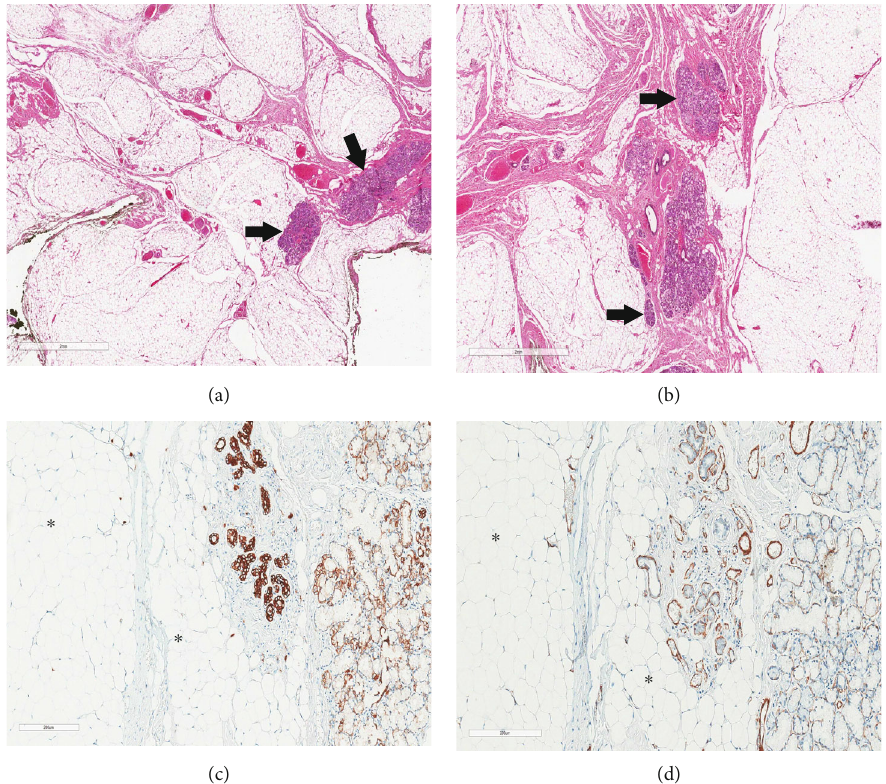
Figure 3: (a, b) Peripheral and inner areas of the tumor showing thin fi brous tissue capsule with numerous fat lobules and separated with fi brous tissue septae rich in vascular tissue with islands of salivary gland tissue (arrows) within the lipomatous proliferation. Scale bars: 2mm. (c) Pancytokeratin (AE1/AE3) expression in the ductal and acinar cells in the entrapped salivary gland. The adipose tissue was negative (asterisk). Scale bar: 200 μ m. (d) Smooth muscle actin highlighting the myoepithelial cells around the acini and ducts, and the smooth muscle in adjacent vascular structures. Lipomatous elements were negative (asterisk). Scale bar: 200 μ